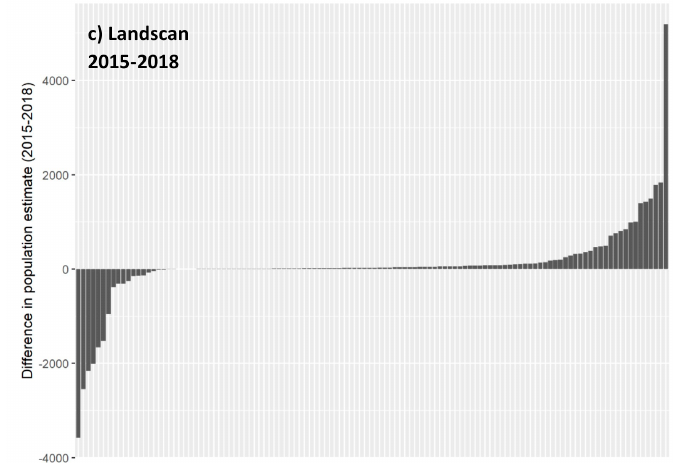
Figure A2. Difference in multiple-time point gridded population estimates in 134 slum settlements for ( a ) GPWv4.11 between 2015 and 2020, ( b ) WorldPop-Unconstrained between 2015 and 2018, and ( c ) LandScan between 2015 and 2018.